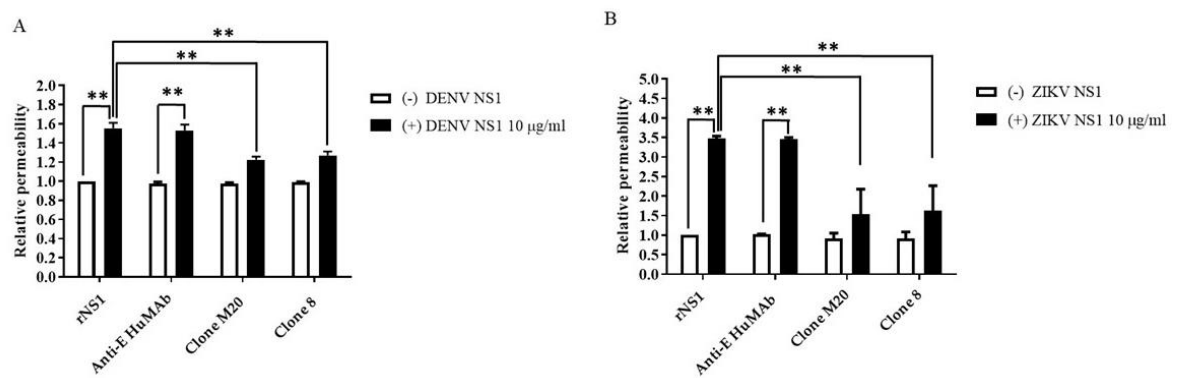
Figure 4. DENV NS1 HuMAbs protect NS1-mediated endothelial leakage in vitro: monolayer of HMEC-1 and HUVECs cells are grown on Transwell inserts and incubated with ( A ) DENV NS1 or ( B ) ZIKV NS1 alone or NS1 with either anti-E HuMAb or anti-DENV NS1 HuMAbs; M20 and 8. Untreated cells are used as a negative control. After 24 h treatment, endothelial permeability has been evaluated by measuring the HRP activity. The results are presented as the average of mean ± SD of two independent experiments. ** p-value < 0.01 indicates a significant difference.